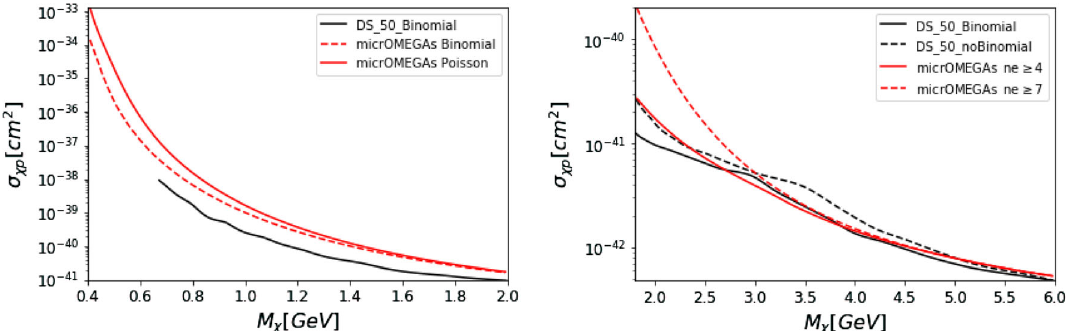
Fig. 3 Comparison between the 90% excluded SI cross section on protons from DS-50 with a binomial distribution (full black) and from micrOMEGAs with the default option, a Poisson distribution using all bins with n e − ≥ 4 (full red). The left panel also shows the exclusion for light masses when using a binomial distribution in micrOMEGAs